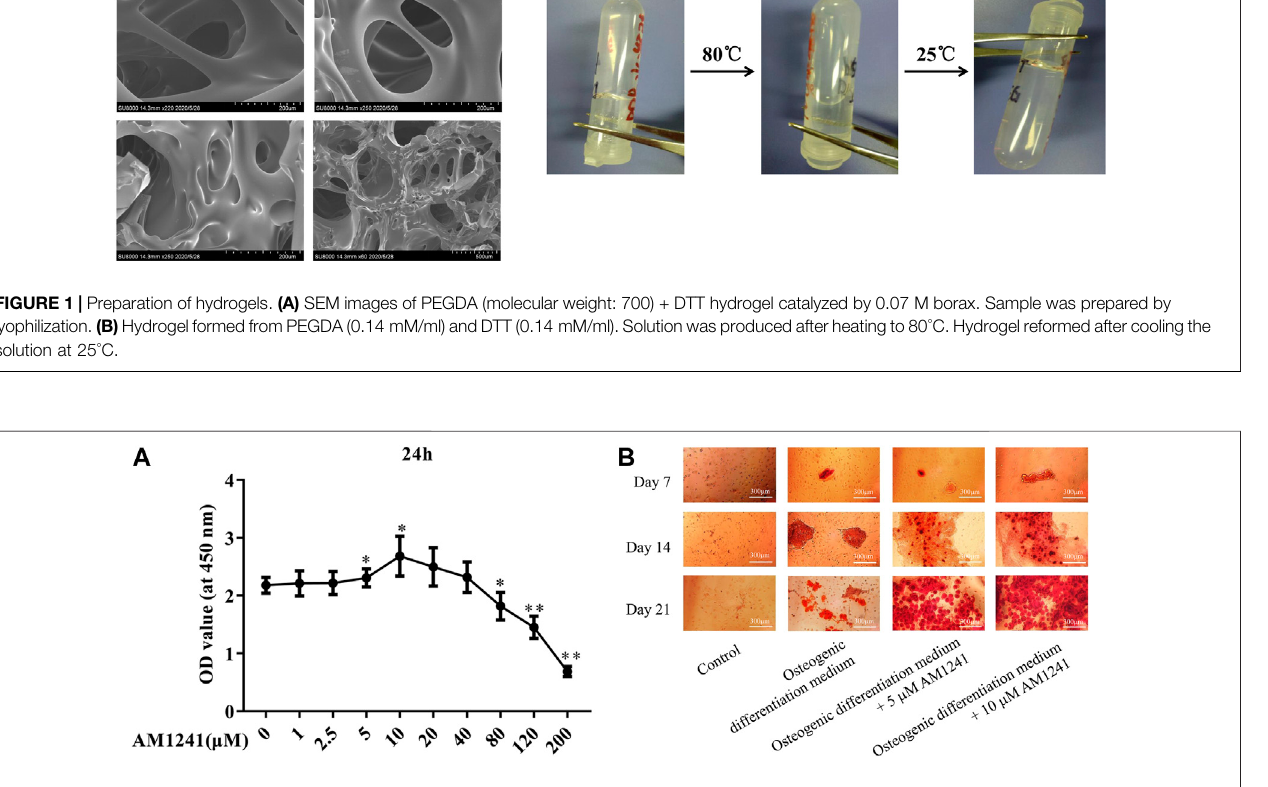
FIGURE2| Effect ofAM1241on osteoblasts invitro. (A) CCK-8assayofdetermining the optimal concentrationofAM1241bythe effect ofAM1241on theactivity of BMSCs. (B) AR staining of osteogenic differentiation experiment of BMSCs.